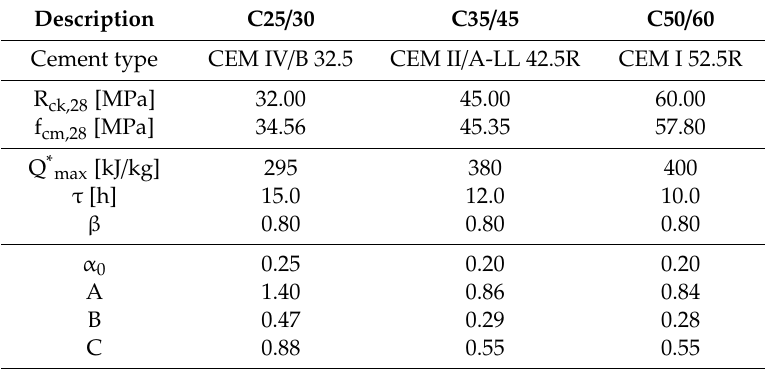
Table 1. Concrete mixture